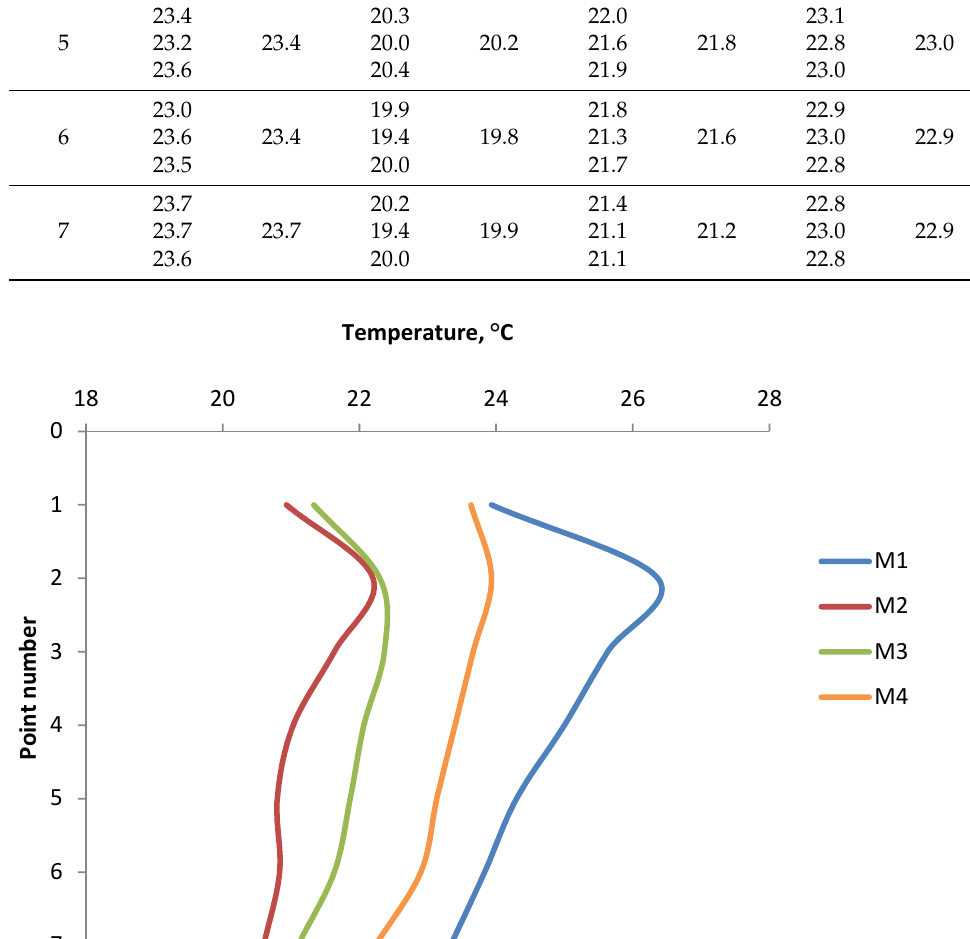
Figure 11. The temperature distribution on the front side briquette surfaces .